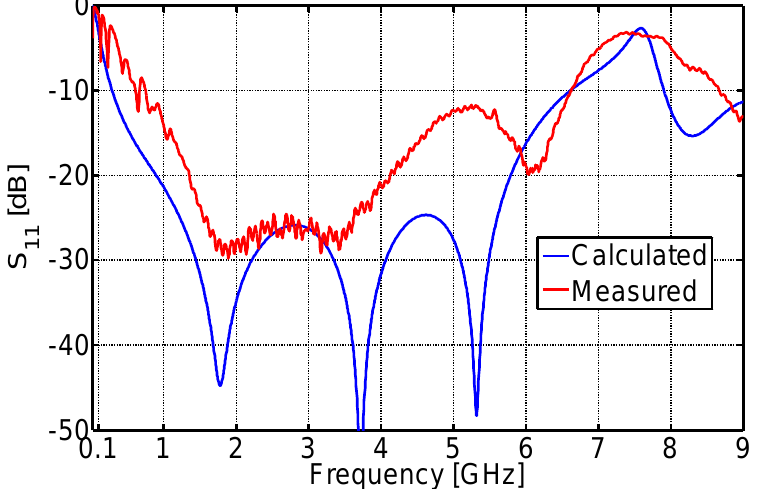
Figure 16. Calculated and measured input reflection coefficient ( S 11 ) of the adiabatic transmission line .